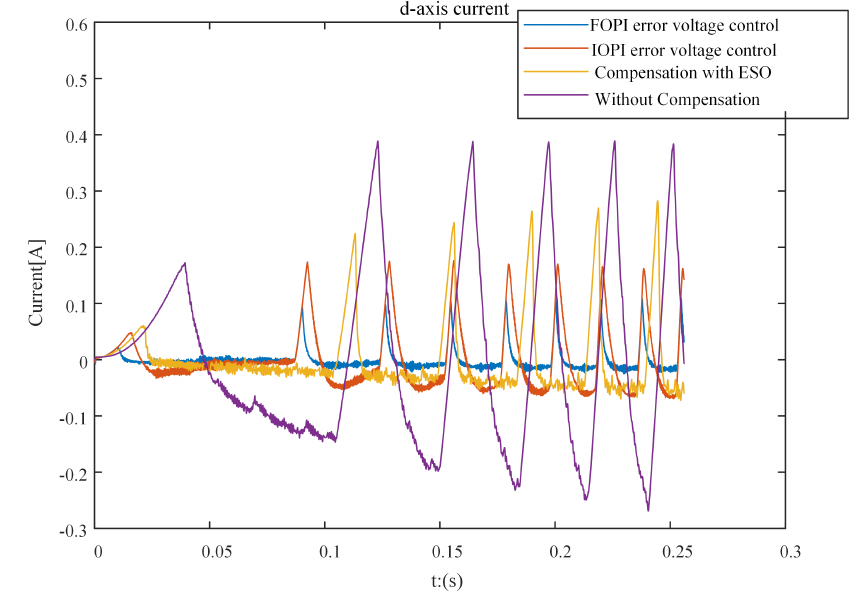
Figure 14. Comparison of I d current response of three control